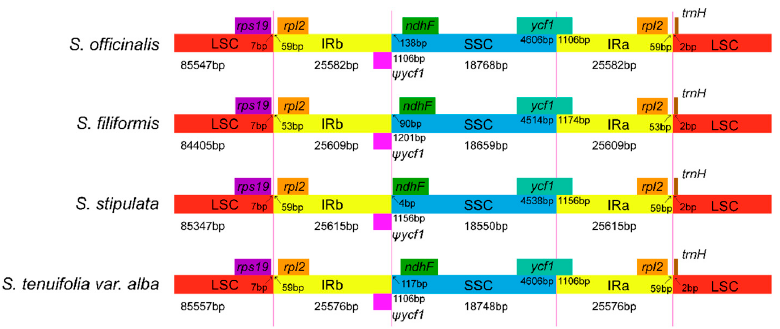
Figure 2. Comparison of the border regions of the LSC, SSC, and IR among four chloroplast genomes. Ψ : pseudogenes.